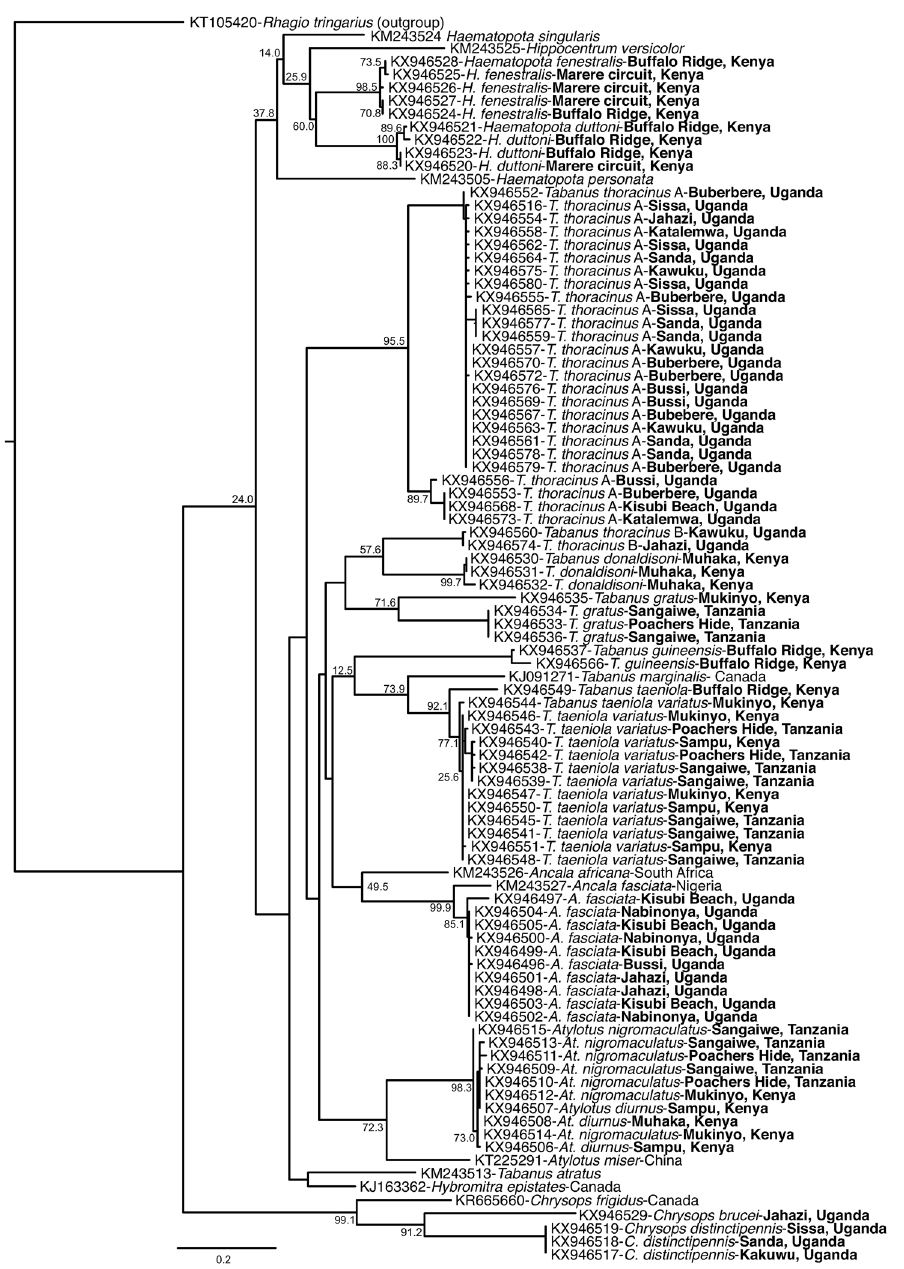
Figure 2. Maximum likelihood phylogenetic tree of Tabanidae COI sequences. Sequences from samples collected in Kenya, Tanzania and Uganda alongside reference sequences obtained from GenBank. Gen- Bank accessions, tabanid species and sampling locations (where available) are shown. Study sequences are indicated with sampling sites in bold. The branch length scale bar indicates nucleotide substitutions per site. Bootstrap values at the major nodes are of percent agreement among 1000